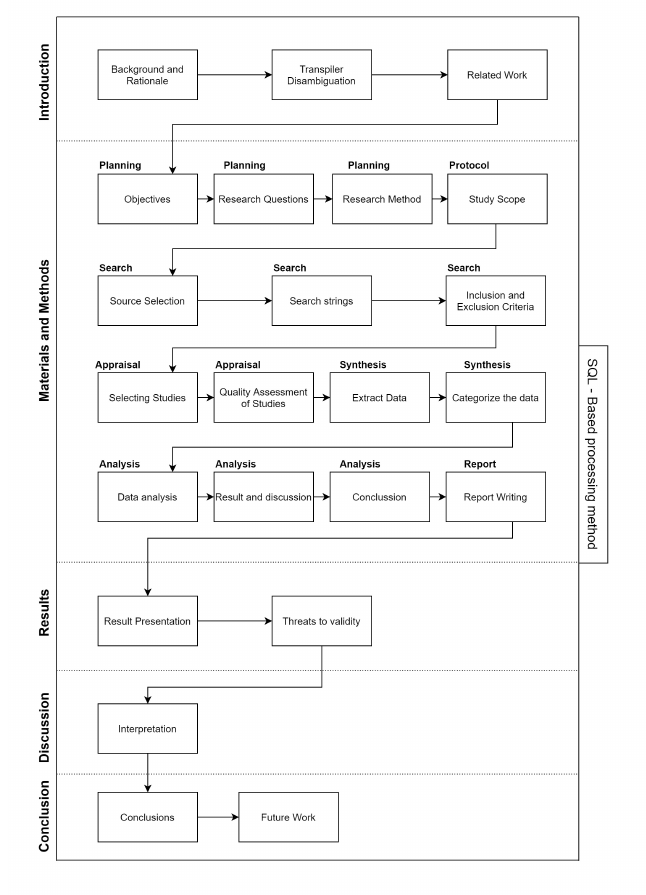
Figure 1. Article content